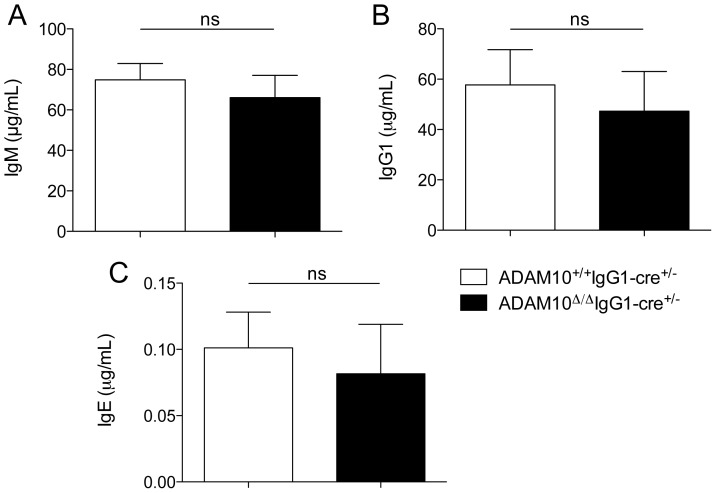
ADAM10Δ/ΔIgG1-cre+/− mice have normal basal antibody levels.Serum (A) IgM, (B) IgG1, and (C) IgE were measured by capture ELISA from 8- to 12-wk-old mice. ns: non significant.